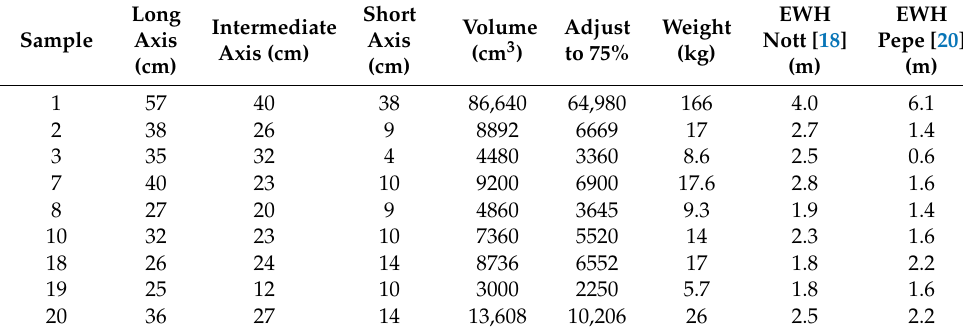
Table A5. Quantification of boulder size, volume, and estimated weight from all coastal bar boulder through transect 5 at Bah í a San Luis Gonzaga. The density of Baja Californian andesite at 2.3 gm / cm 2 is applied uniformly in order to calculate wave height for each